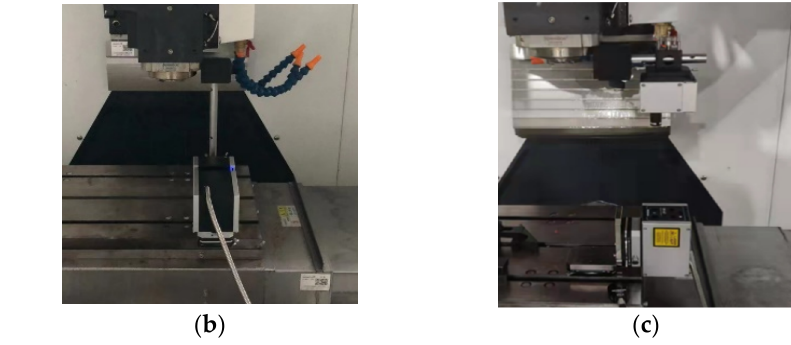
Figure 7. Positioning thermal error measurement. ( a ) X-axis. ( b ) Y-axis. ( c ) Z-axis.